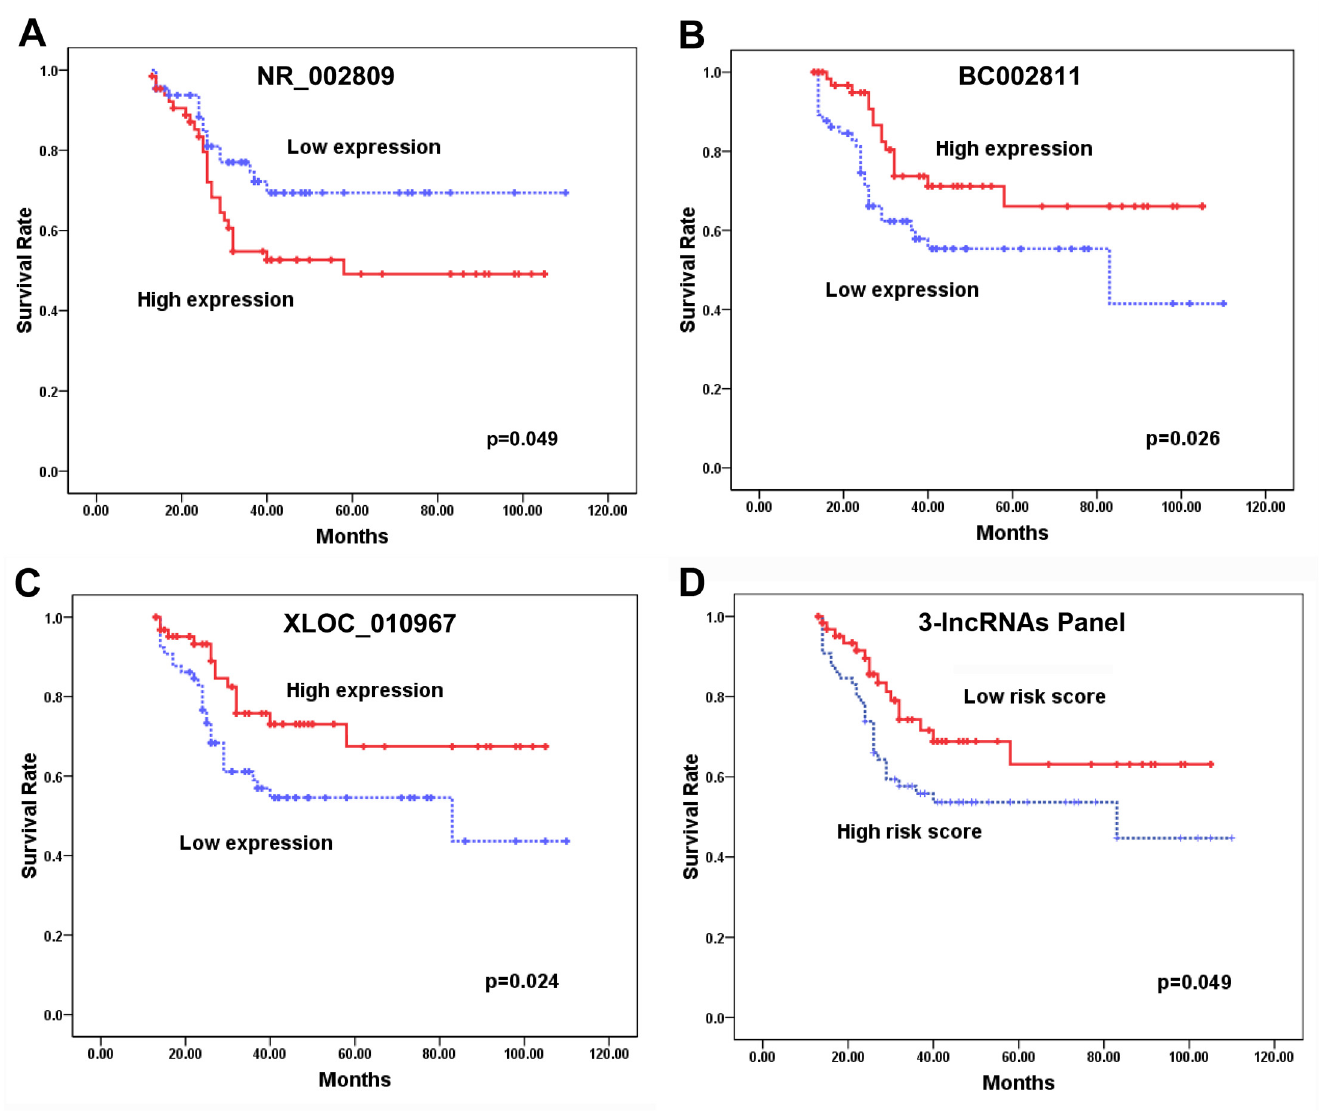
Fig 3. The relationship between the lncRNA expression levels and the survival time of the astrocytoma patients. (A) Kaplan-Meier survival analysis of the astrocytoma patients stratified according to the expression level of NR_002809. (B) Kaplan-Meier survival analysis of the astrocytoma patients stratified according to the expression level of BC002811. (C) Kaplan-Meier survival analysis of the astrocytoma patients stratified according to the expression level of XLOC_010967. (D) Kaplan-Meier survival analysis of the astrocytoma patients according to the 3-lncRNA signature stratified by risk score.